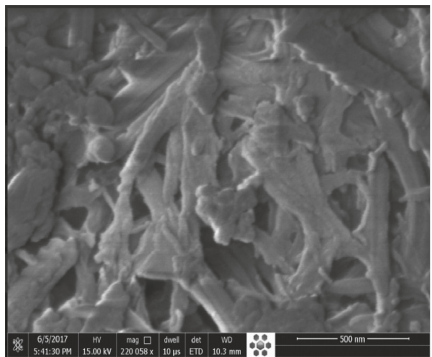
Figure 7: XRD patterns of AGB, cement, and AGB